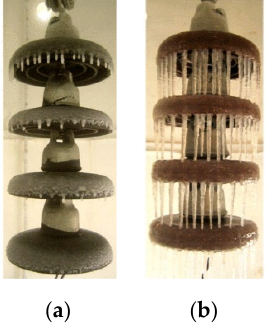
Figure 22. Results of 4-h icing with and without a coating of insulators. ( a ) With coating. ( b ) Without coating [49].